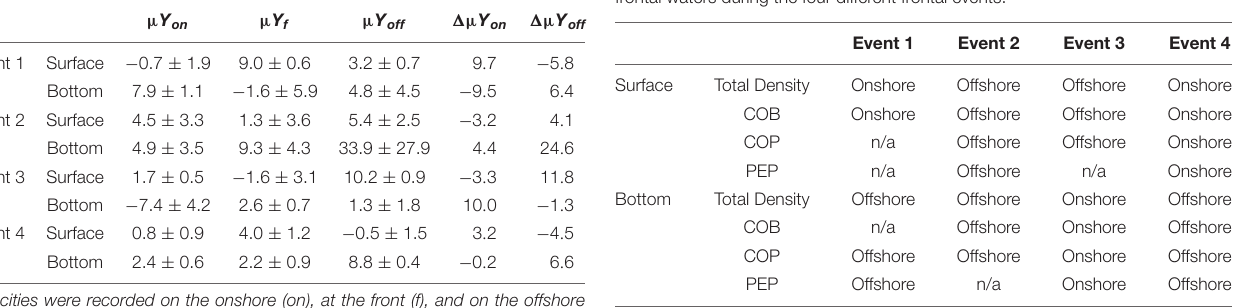
Preflexion larvae comprised roughly 50% of the larval fish catch and larvae in the flexion stage of development contributed 36.6% to the total catch with 10.2% of the total catch consisting of postflexion